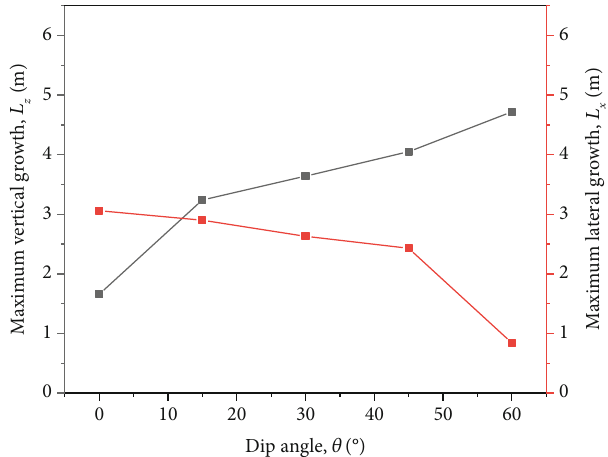
Figure 18: Variation of the maximum deviation angle for di ff erent NF dip